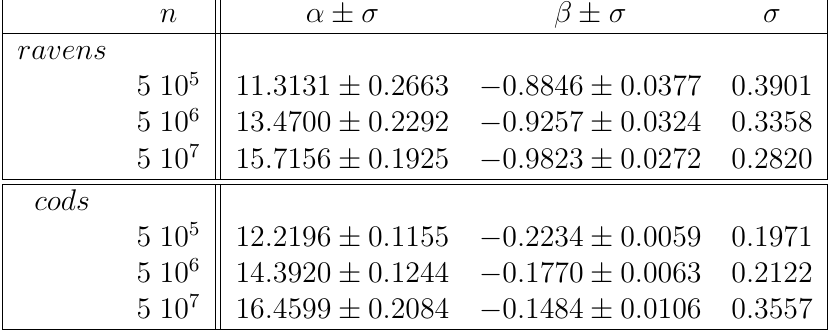
Table 5: Initial branches of Π